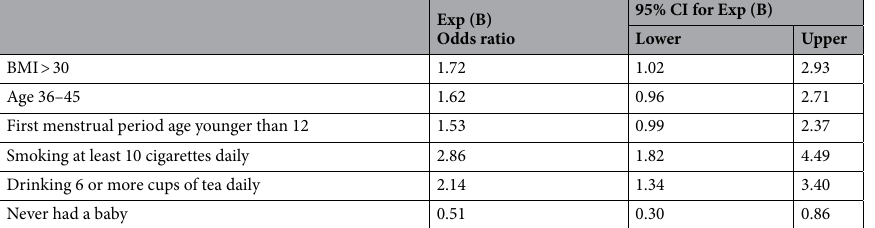
Exp (B) Odds ratio